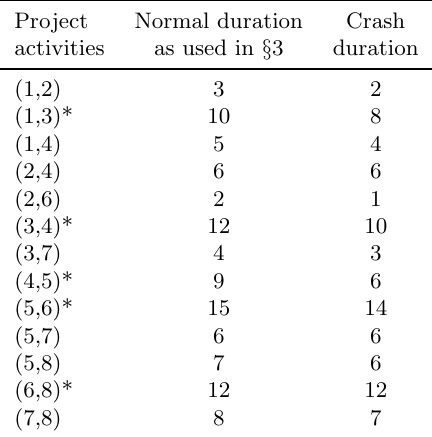
Table 3. These crash durations refer to the shortest possible duration of a specific activity, when faced with a possible time/cost reduction. For example, it would be possible to complete activity (3 , 4) in 10 units of time instead of the normal 12 units of time, while activities (5 , 7) and (6 , 8) cannot be completed in a shorter duration of time.